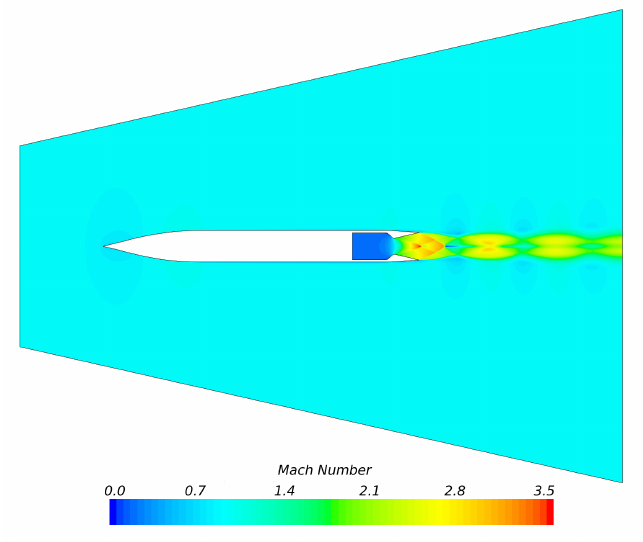
Figure 5. Overview of the flowfield inside and around the nozzle Configuration 2 at M ∞ = 0.9 and NPR =